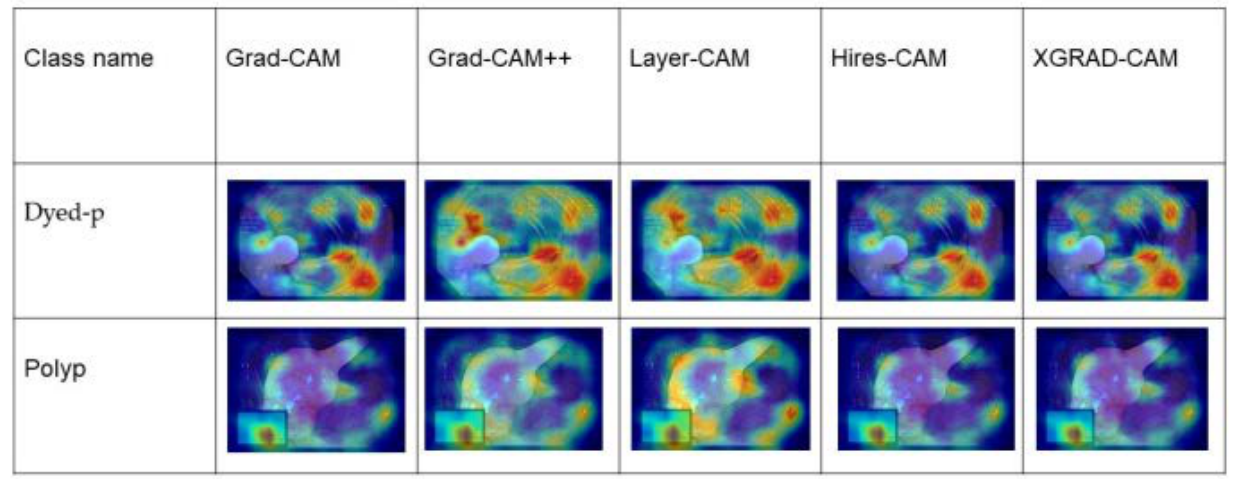
Figure 8 . The output of the explainable heat map for dyed - p and polyp. Figure 8. The output of the explainable heat map for dyed-p and